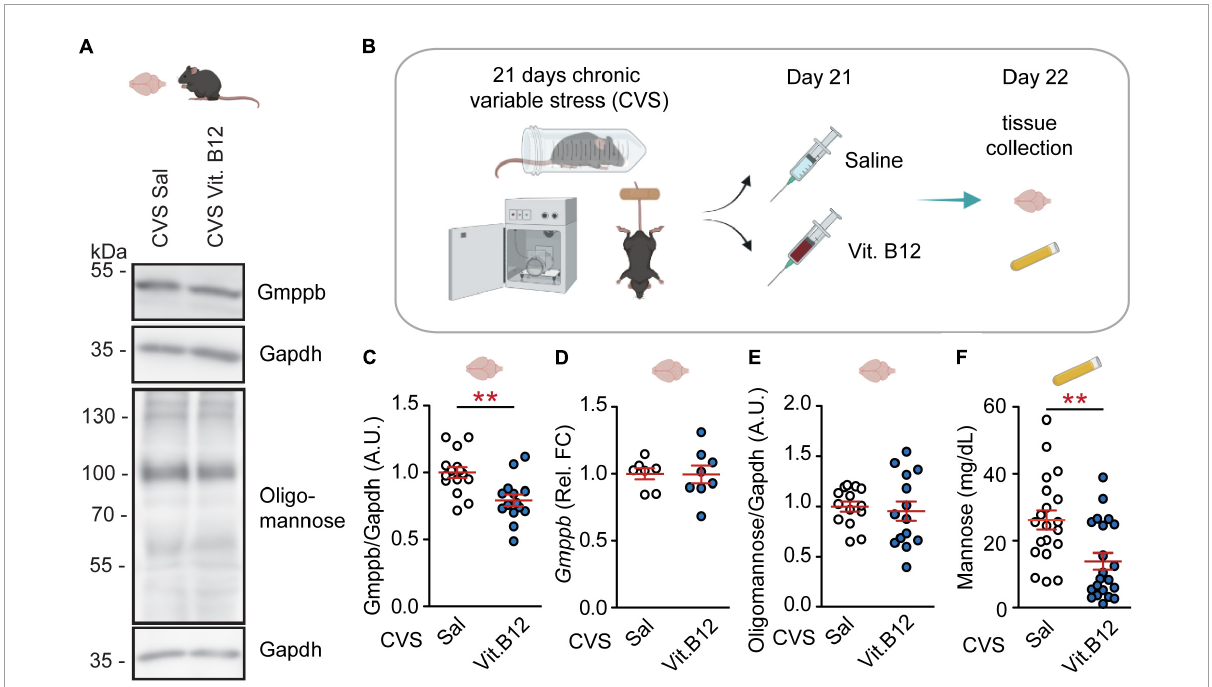
FIGURE2 Vitamin B12 rapidly reverses GMPPB levels and plasma mannose in stressed mice. (A) Representative western blots. (B) Experimental setup for Vitamin B12-experiment. (C–F) Statistics: Student’s t -test. (C) Vitamin B12 reduces GMPPB protein-levels in the PFC of stressed mice; n = 14–15 per group; t 27 = 3.43, ** P < 0.01. (D) No effect of vitamin B12 on Gmppb transcription; n = 7–8 per group; t 13 = 0.05, P = 0.96. (E) No effect of vitamin B12 on oligomannose abundance in the PFC; n = 14 per group; t 26 = 0.42, P = 0.68. (F) Vitamin B12 reduces plasma mannose in CVS-treated mice; n = 20–21 per group; t 39 = 3.23, ** P < 0.01. (C–F) Individual data points are plotted and means ± s.e.m. are shown. A.U., Arbitrary units. Illustrations were generated with